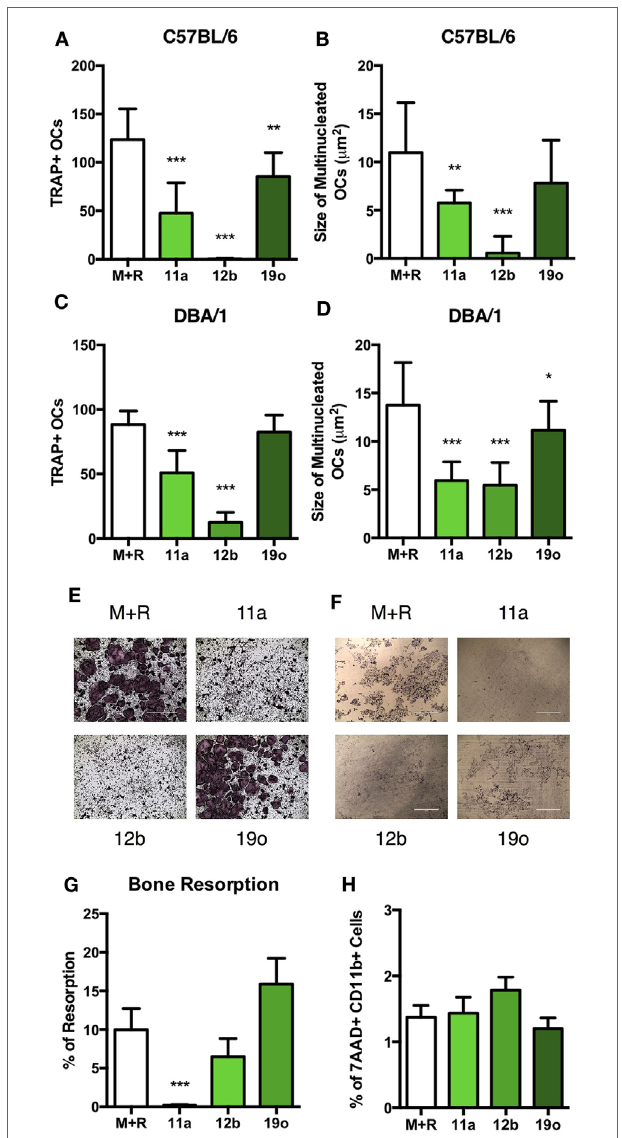
FigUre 4 | SMAs of ES-62 inhibit the differentiation and function of OCs. Non-adherent bone marrow (BM) from naïve C57BL/6 and DBA/1 mice was harvested and cultured for 4 days with 30 ng/ml M-CSF and 50 ng/ml RANKL, at which point medium was refreshed and cells were incubated in medium or medium containing 5 µg/ml SMA 11a, 12b, or 19o. OC differentiation was assessed at day 5 by TRAP staining and Image J was employed to measure the number and size of OCs present (a–D) . Representative images of TRAP-stained SMA-treated OCs are provided [ (e) scale bar = 1,000 µm]. The functional capacity of SMA-treated C57BL/6 OCs was assessed on dentine slices after 14 days, where SMAs were